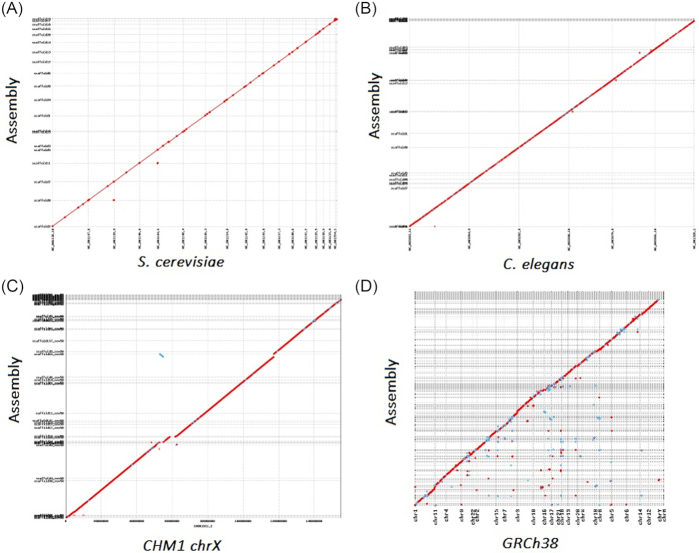
MUMmerplot of new assemblies generated by strategy 5 compared to the reference assemblies. Alignment dot plots show the structural agreements between the new assemblies (y-axis) and the reference (x-axis). Boundaries of chromosome from the reference and of scaffolds from the assemblies are represented as dotted lines (vertical and horizontal, respectively). Scaffolds are oriented and ordered to match the chromosomes using “mummerplot” command with “–filter –layout” option. (A) Plot between the new assembly and S. cerevisiae reference. (B) Plot between the new assembly and C. elegans reference. (C) Plot between the new assembly and CHM1 HsX reference. (D) Plot between the new CHM1 assembly and GRCh38 reference.